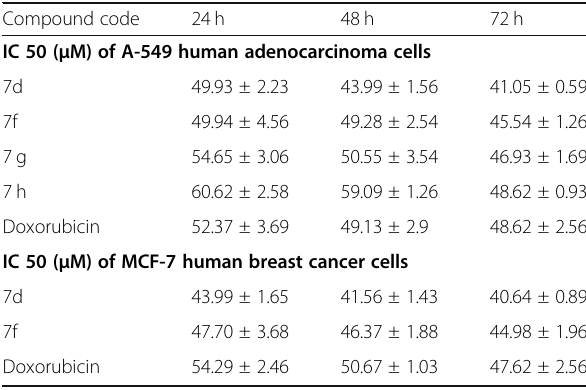
Table 3 Anticancer activity of targeted quinazoline derivatives Compound